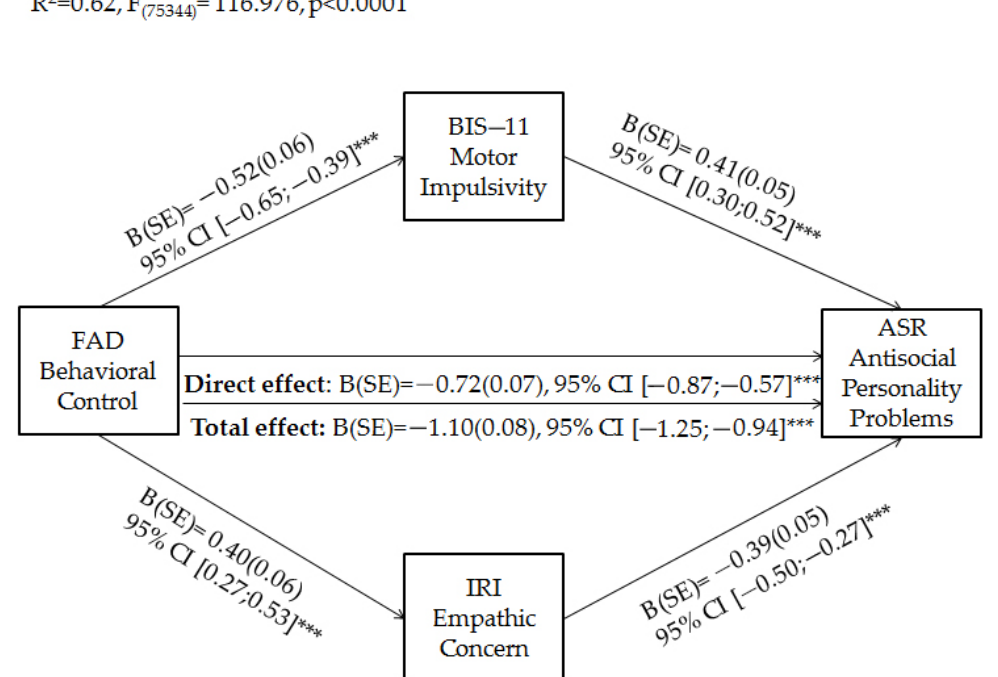
Figure 2. Parallel mediation of motor impulsivity and empathic concern on the relationship between parental behavioral control and emerging adults’ antisocial personality problems. *** p <